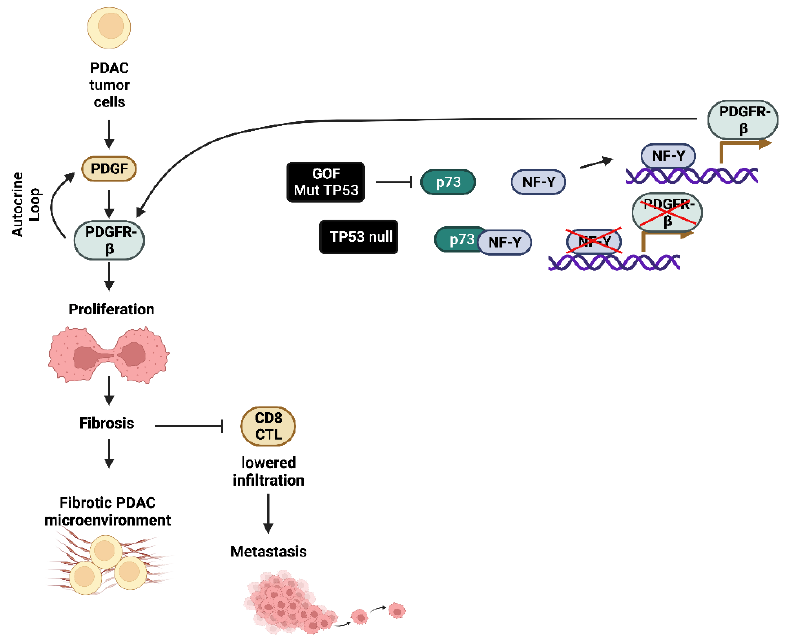
Figure 5. Effects of GOF mut-TP53 on PDGF-R β Expression in PDAC Tumor Cells Growth, Fibrosis and Metastasis. CD8 + cytotoxic T lymphocyte (CD8 + CTL), TP53 family member p73 (p73), nuclear factor-Y transcription factor (NF-Y).